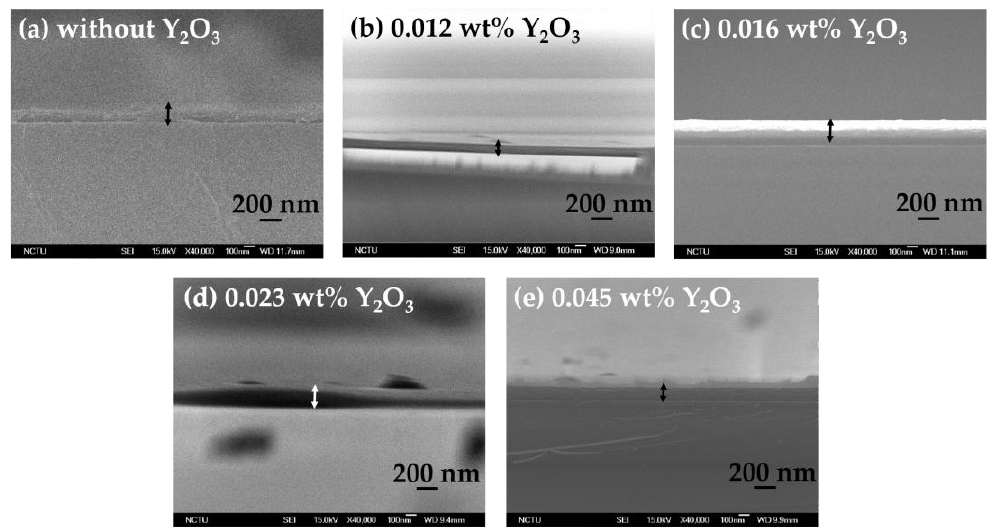
Figure 5. Cross-section images of the blended Y 2 O 3 /chitosan thin films: ( a ) Without Y 2 O 3 ; ( b ) 0.012 wt %; ( c ) 0.016 wt %; ( d ) 0.023 wt %; and ( e ) 0.045 wt %.